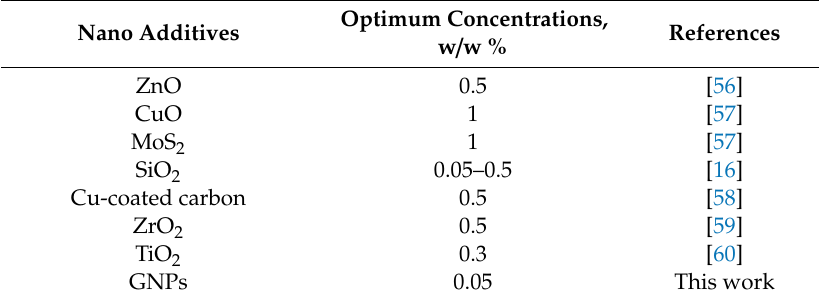
Table 2. Optimal concentrations of nano-additives for di ff erent lubricant oils.